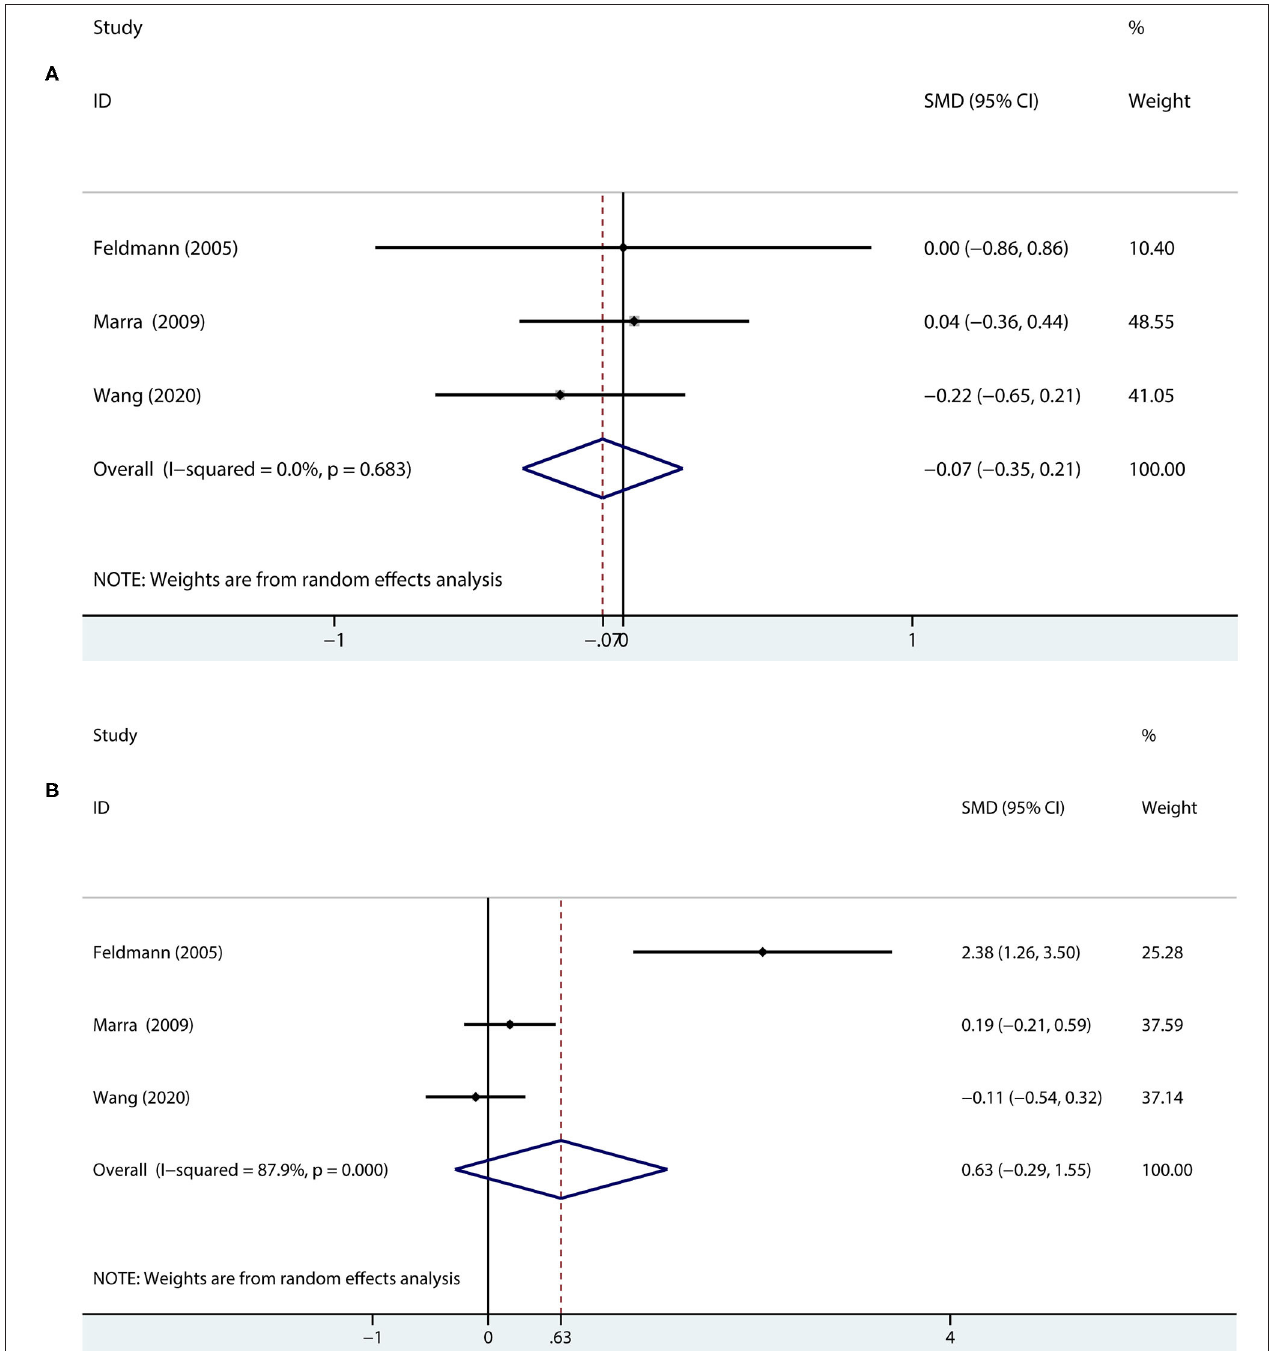
FIGURE 4 | A forest plot of the association between the severity of MG and memory. (A) In terms of immediate recall memory, the patients with Class II MG were compared with the patients with Class I MG. (B) In terms of delayed recall memory, the patients with Class II MG were compared with the patients with Class I